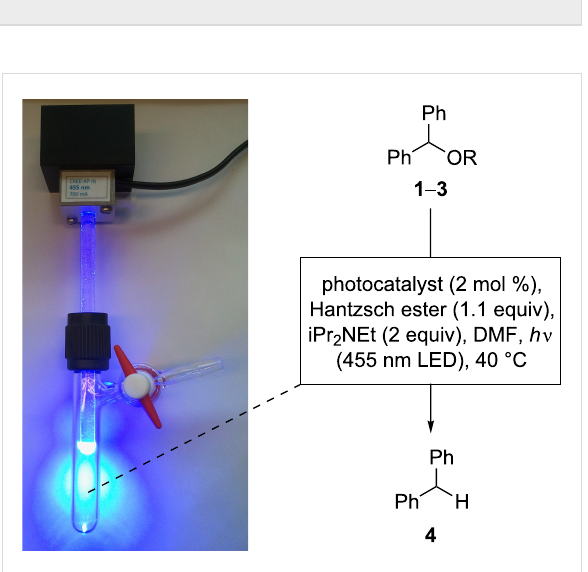
Scheme 2: Reduction potentials of investigated derivatives 1 – 3 in